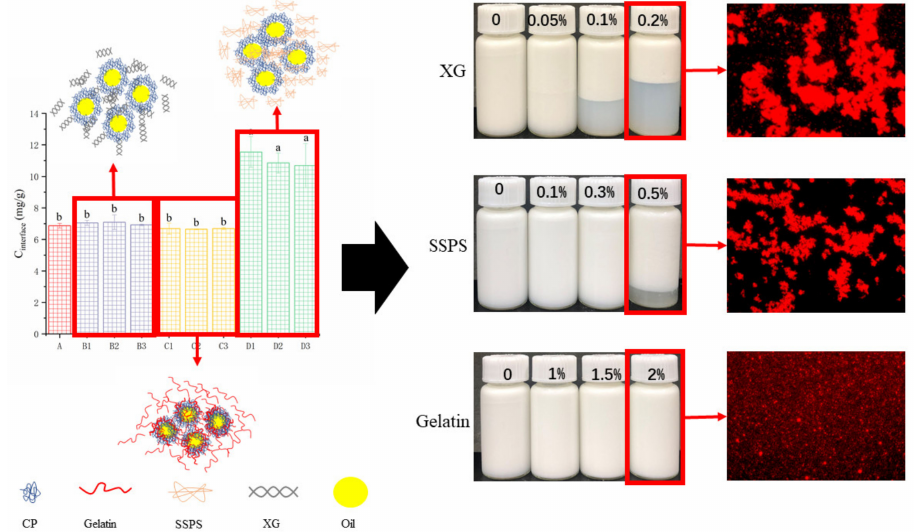
Figure 11. The different emulsification mechanisms of CP-Hydrocolloid systems. (CP—Coconut protein, XG—Xanthan gum, SSPS—Soluble soybean polysaccharide, A—CP, B—“CP-XG”, C—”CP-SSPS”, D—“CP-Gelatin”, “1–3” represents the concentration increase). Letters a, b indicate significant difference in different systems ( p <